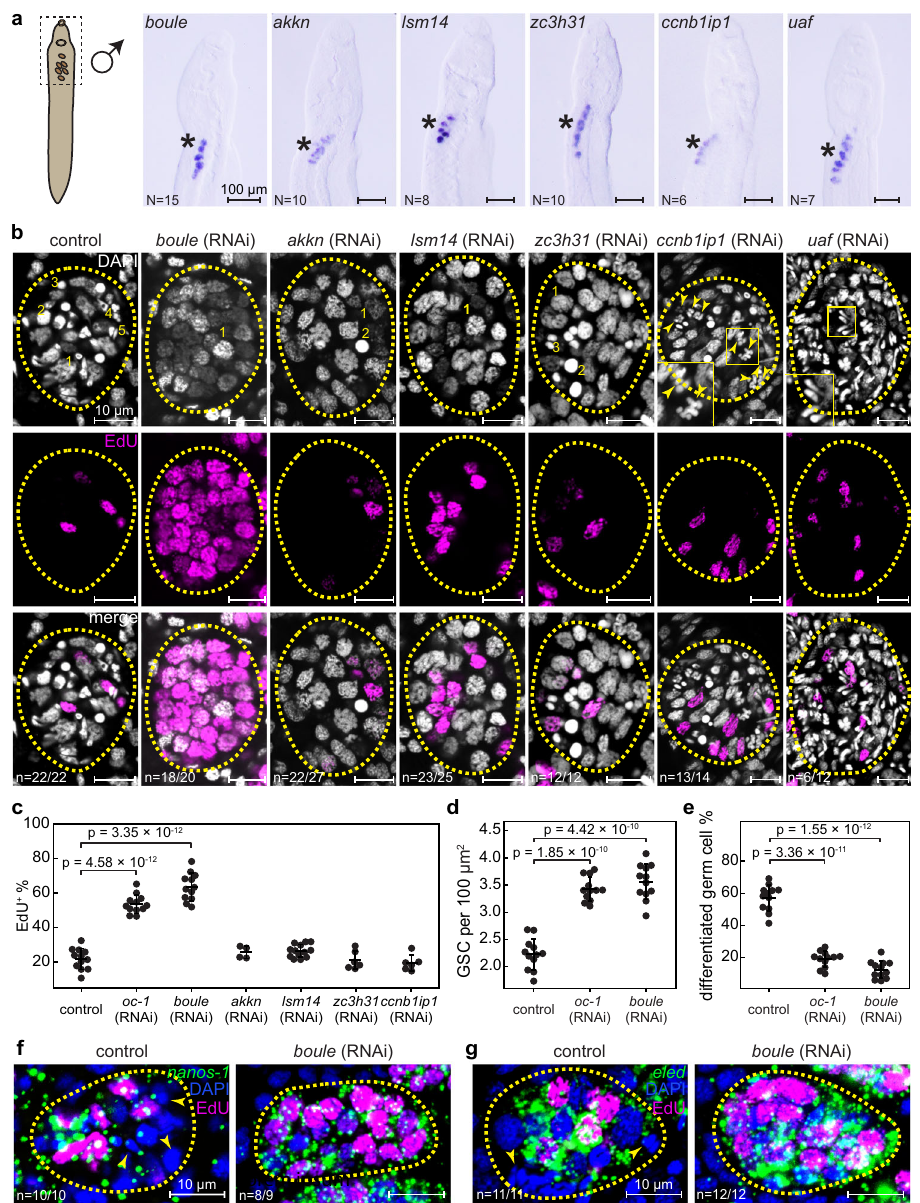
Fig. 3 An RNAi screen identi fi es that boule phenocopies oc-1 after RNAi in the juvenile male germline. a WISH images showing the expression of boule , akkn , lsm14 , zc3h31 , ccnb1ip1 , and uaf in male juvenile parasites. Asterisks: testes. The imaged areas correspond to the dashed box in the schematic on the left. N : number of samples showing similar results over two independent experiments. b Confocal images showing representative individual testis lobules stained by DAPI and EdU in control and boule , akkn , lsm14 , zc3h31 , ccnb1ip1 , and uaf RNAi juvenile parasites. Insets: magni fi ed boxed areas. Dashed circles: testis lobule boundary. Arrowheads in ccnb1ip1 RNAi image: incomplete separation of meiotic nuclei. Nuclear morphologies are labeled in the images as in Fig. 2c. c Fraction of EdU + nuclei, d number density of GSCs and e fraction of differentiated germ cells in testes in control and RNAi parasites. Each data point represents the mean across all testis lobules in a single parasite. N = 12 (control RNAi); N = 12 ( oc-1 RNAi), N = 12 ( boule RNAi), N = 4 ( akkn RNAi); N = 13 ( lsm1 RNAi); N = 6 ( zc3h31 RNAi); N = 6 ( ccnb1ip1 RNAi). Data are plotted as average ± standard deviation and p-values are calculated using two- sided Welch ’ s t -test. f , g FISH images showing broader expression of nanos-1 ( f ) and eled ( g ) in testes after boule RNAi. Arrowheads: differentiated germ cells that do not express nanos-1 or eled . n : number of samples exhibiting the reported phenotype out of the total number of samples analyzed. RNAi experiments were repeated on at least three biological An RNAi screen identi fi es boule as a germline regulator that down (Supplementary Data 2), we observed male germline phenocopies oc-1 after knockdown . To identify the pathway developmental defects in RNAi experiments of 6 genes (Fig. 3a). through which oc-1 functions, we performed an RNAi screen to Of these, only the knockdown of boule gave rise to a similar but knockdown genes enriched in GSCs identi fi ed by scRNAseq, stronger phenotype compared to that of oc-1 RNAi (Fig. 3b – g): focusing on predicted RNA binding proteins, enzymes, and testis lobules contained EdU + nanos-1 + / eled + GSCs at a higher receptors. The goal of these experiments was to identify genes density compared to controls and drastically reduced number of that phenocopy oc-1 upon RNAi. Out of the 39 genes knocked differentiated germ cells. Consistent with its phenotype, we